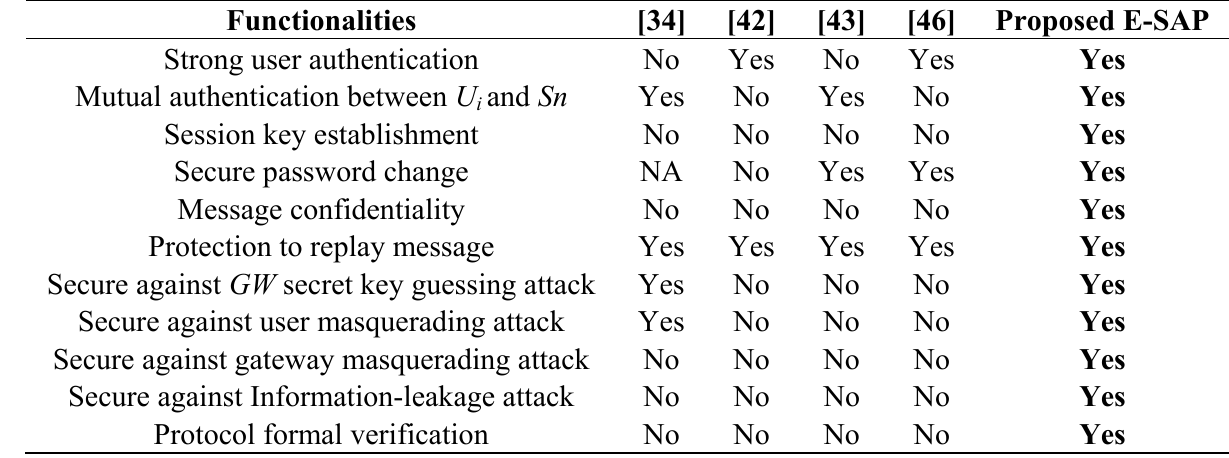
Table 4. Comparison of E-SAP functionality with related